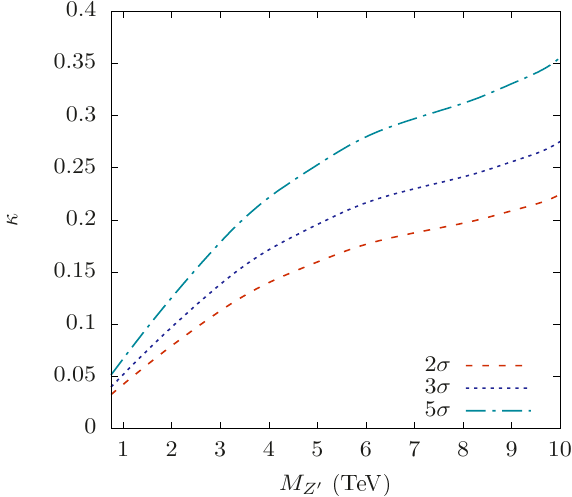
Figure 6. Con(cid:12)dence level contours with signi(cid:12)cance 2 (cid:27) , 3 (cid:27) and 5 (cid:27) in the M Z 0 (cid:0) (cid:20) plane at